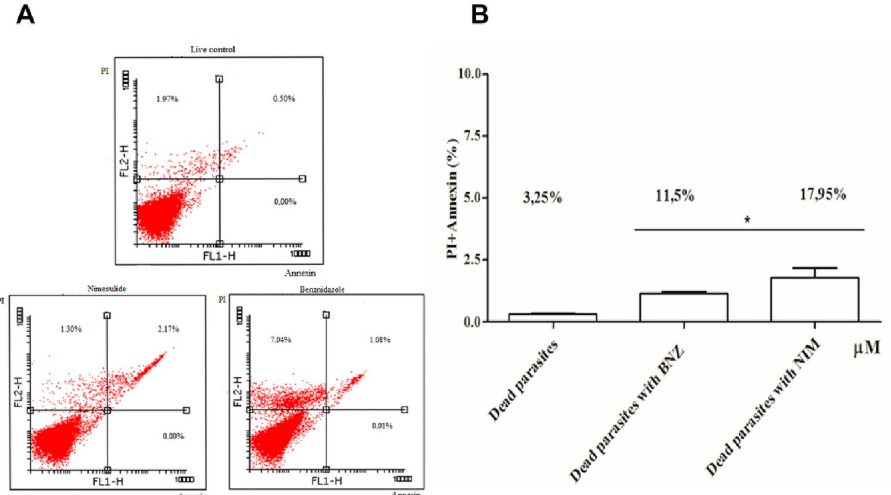
Fig 4. Elucidation of the type of cell death of epimastigotes of T . cruzi (Y strain), in the exponential growth phase, treated with nimesulide and benznidazole, at concentration of 35 μ M, for 24 hours. A : The representative histograms of the parasites treated and marked with propidium iodide for necrosis death, in the FL2-H channel, and marked with annexin for apoptosis death, in the FL1-H channel. It is observed in the upper right region that nimesulide caused twice the death due to apoptosis and necrosis, simultaneously, compared to benznidazole. B . Graphical representation of the percentage of cell death in the cell culture treated with nimesulide. Control corresponds to viable AV-IP-cells. The effect of nimesulide was compared to the results obtained in the treatment with benznidazole and corresponds to late apoptotic cells AV+IP, for both treatments. Representative results from two independent experiments. Asterisk represent the significant difference from the untreated control (p < 0.05).